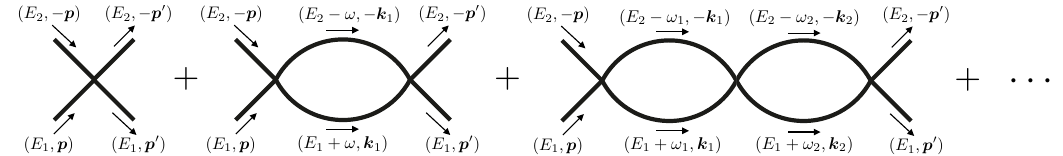
Figure 29 . The EFT scattering amplitude is given by a sum of bubble diagrams.